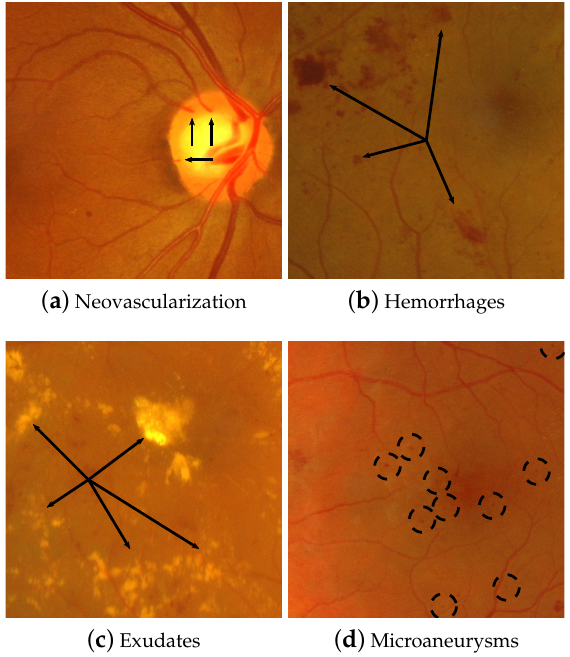
Figure 2. Characteristics elements associated with retinopathies. These elements are indicated with black arrows and dashed